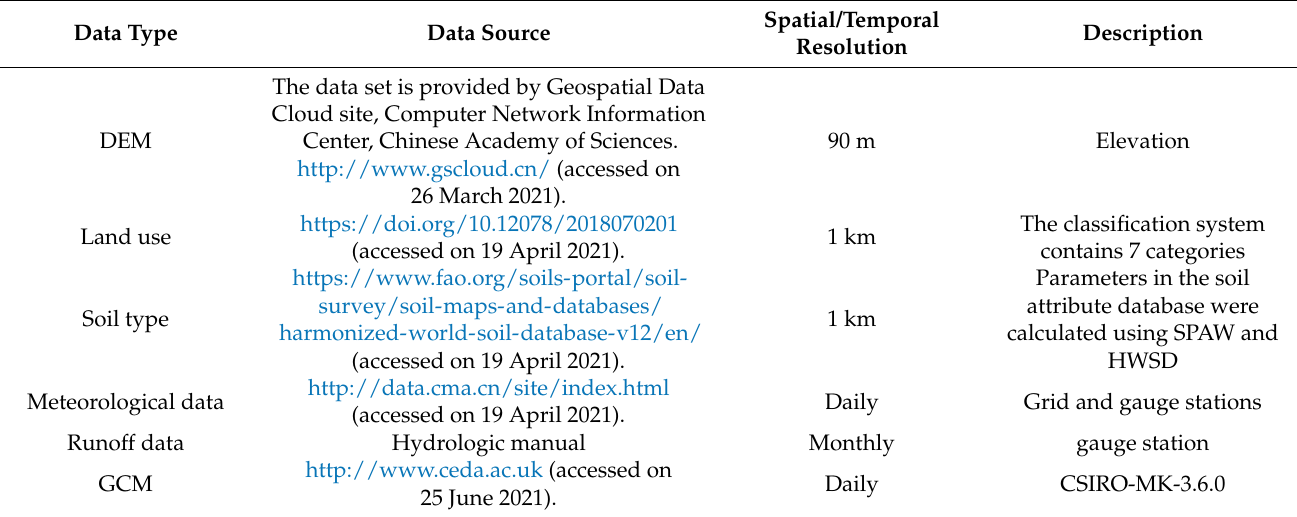
Table 1. Data used in the study and their sources and descriptions.